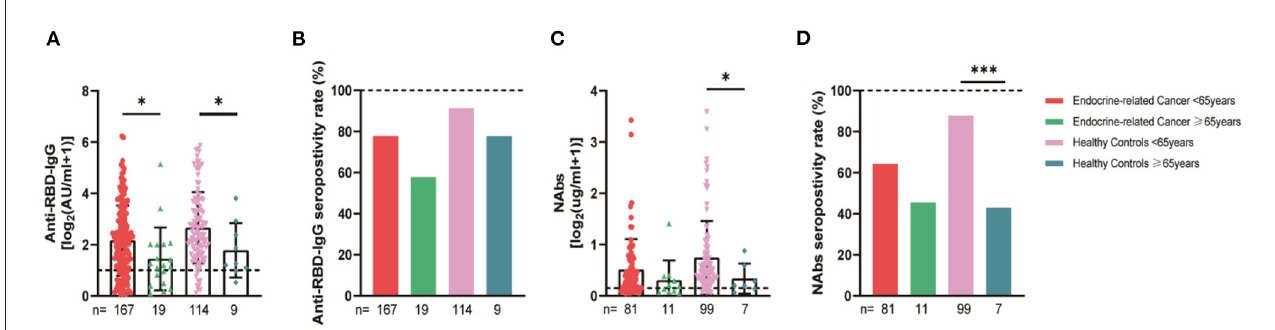
FIGURE3 Antibody responses to inactivated SARS-CoV-2 vaccines in participants of different ages. Subgroup analysis of the titers and seropositivity rate of anti-receptor binding domain (RBD)-IgG (A, B) and NAbs (C, D) in participants according to age (* P < 0.05, *** P < 0.001). The horizontal dotted lines represent the limit of detection. The error bars represent the median (IQR). NAbs, neutralizing antibodies; IQR, interquartile range; RBD, receptor binding domain.